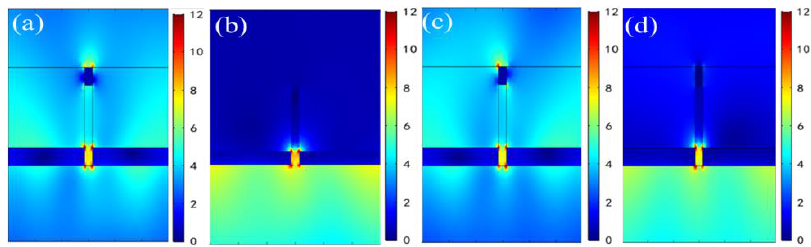
Figure 7. Electric field distributions of two different reflection resonant dips at θ = 10 ◦ for TM polarization from the bottom and the top. ( a ) λ = 772 nm on the bottom; ( b ) λ = 1076 nm on the bottom; ( c ) λ = 772 nm on the top; ( d ) λ = 1076 nm on the top.